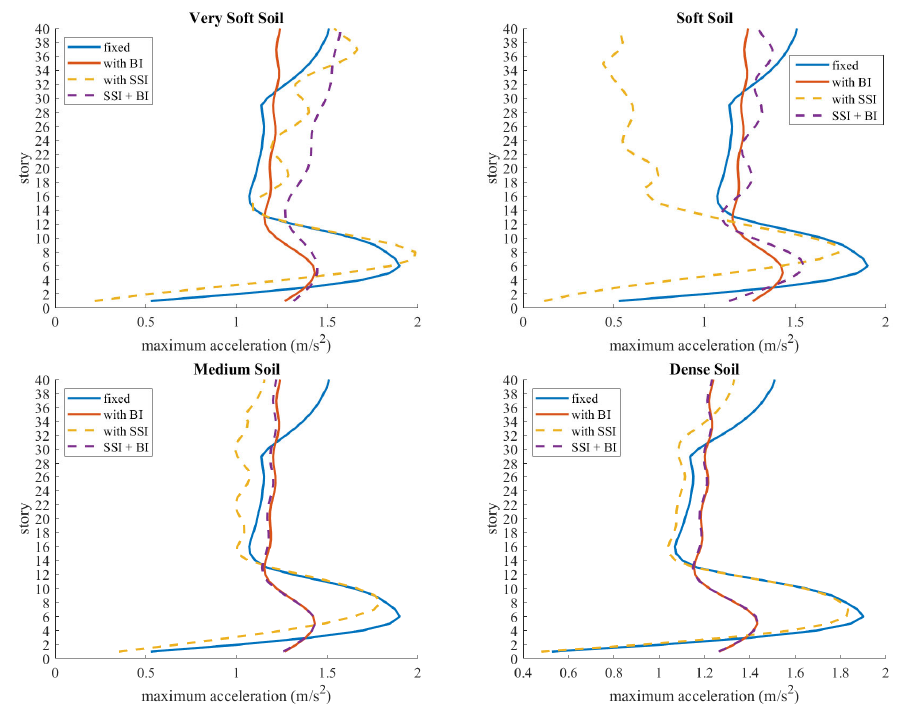
Figure 9. Maximum acceleration of each story for the forty ‐ story building (Imperial Valley, 1979).